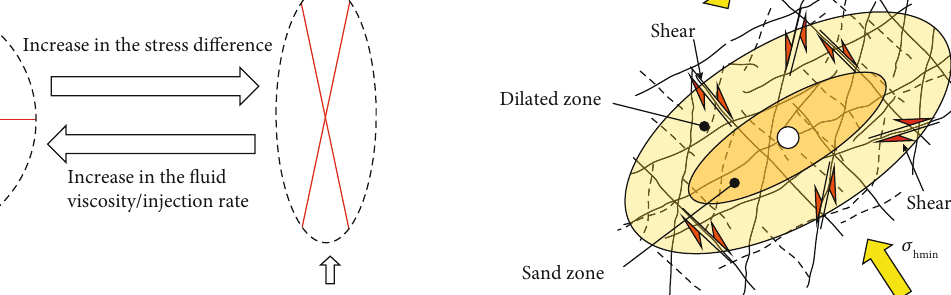
Figure 29: Schematic of the stimulated (dilated) zone around the sand-propped zone